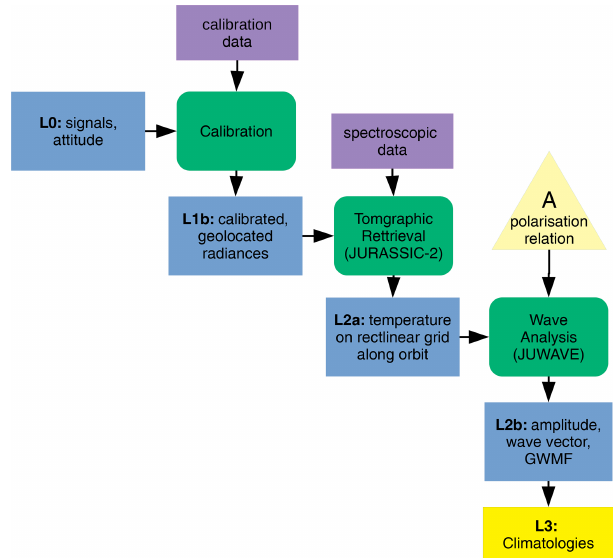
Figure 18. Processing chain including retrieval and GW analysis. Up to a climatology of GWMF in terms of, e.g., zonal means or monthly mean 3-D global distributions (Level 3 data) only data ob- served by the instrument are required.